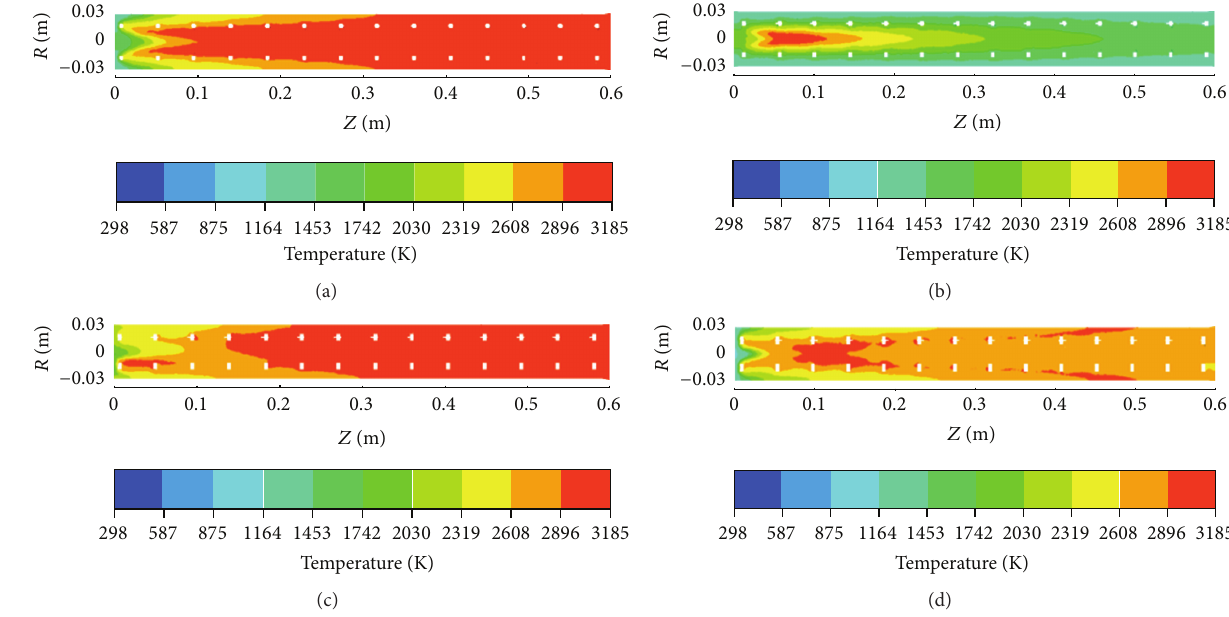
Figure 17: Contour of axial flame temperature distribution generated by an accelerating flame in obstacle landed detonation tube for (a) BR = 0.4, (b) BR = 0.5, (c) BR = 0.6, and (d) BR = 0.7 at Ma = 5 for spacing of 𝑆 = 4 cm [132].